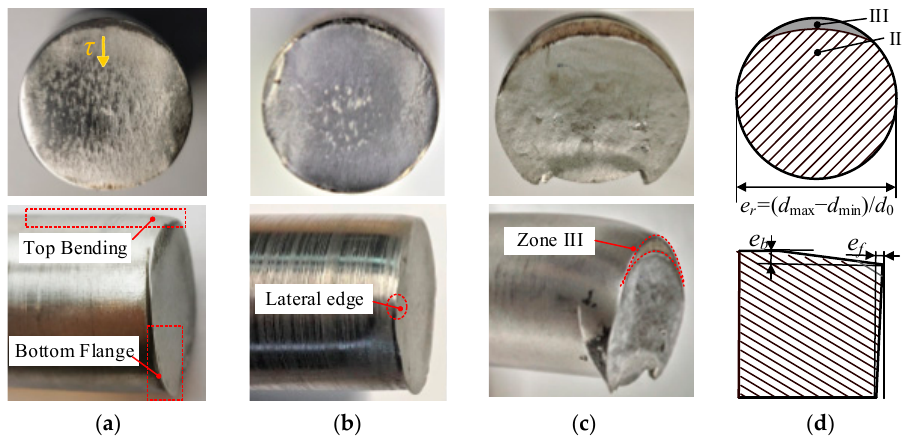
Figure 10 . Macro-fractography for Test 2 without circumferential kerf. ( a ) Q235. ( b ) 40 Cr. ( c ) 304. ( d ) Evaluation indexes.